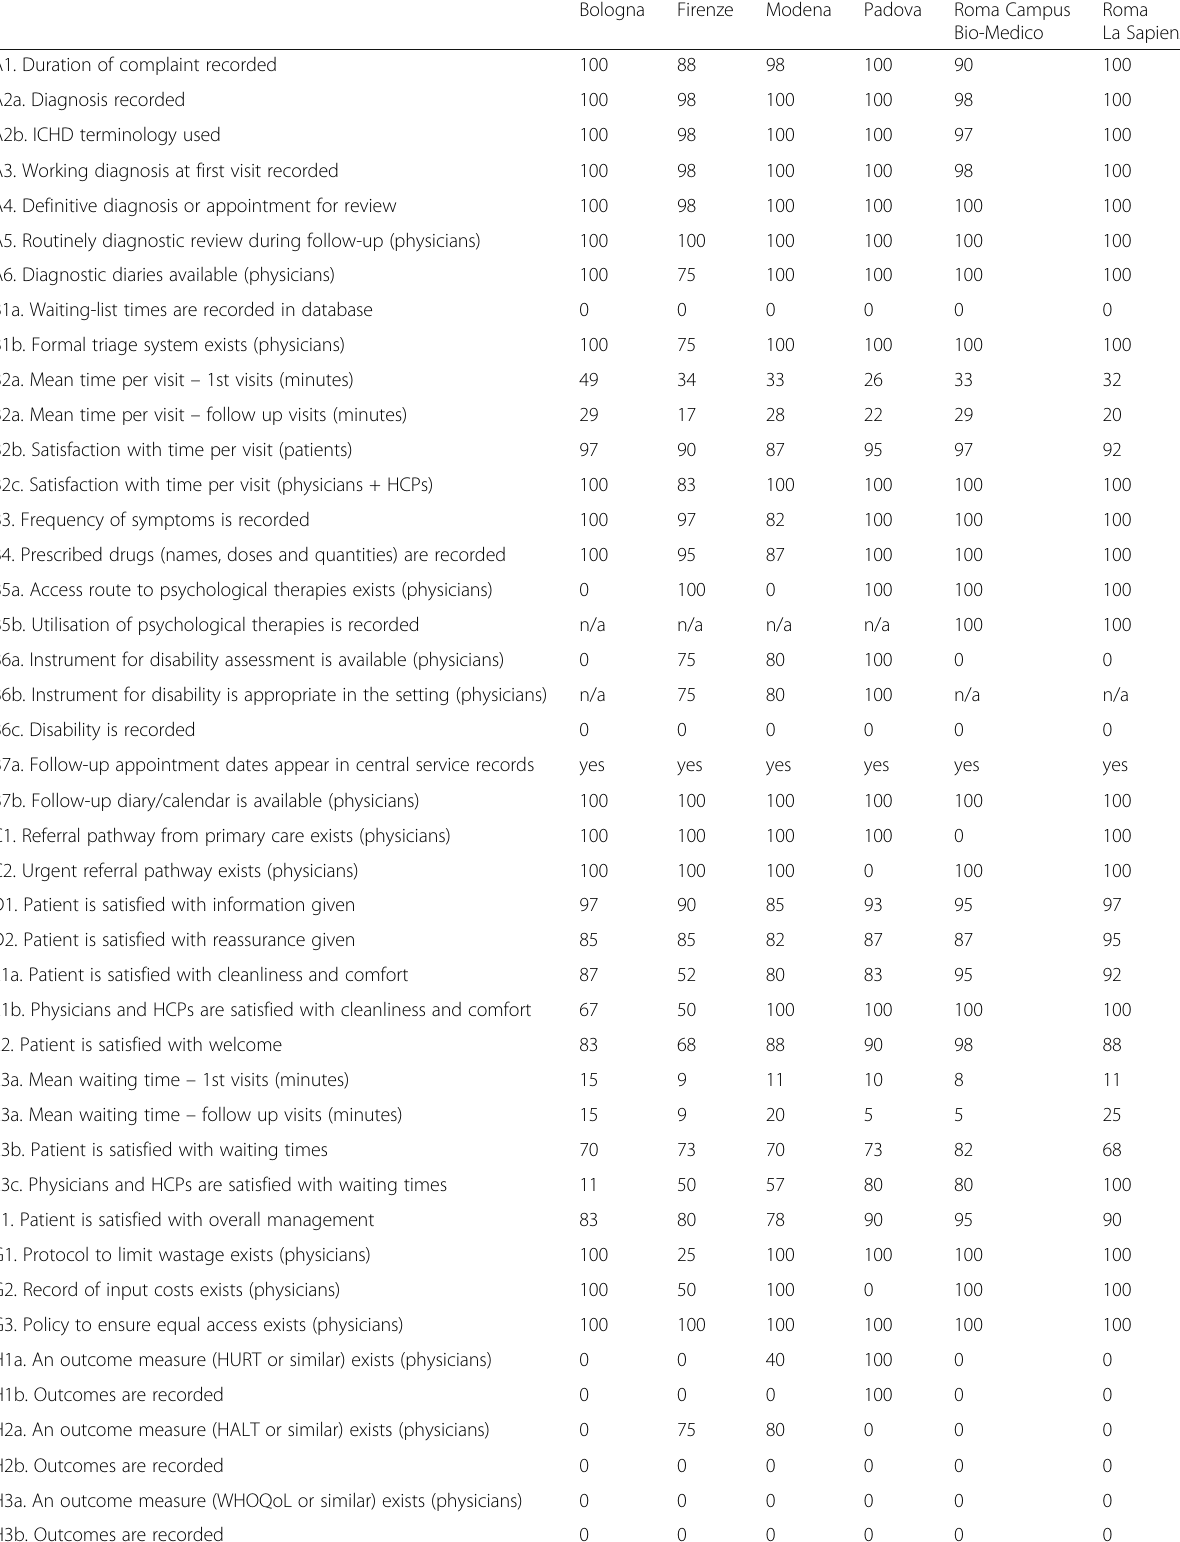
Table 3 Outcomes of implementation of quality indicators by centre (% of positive